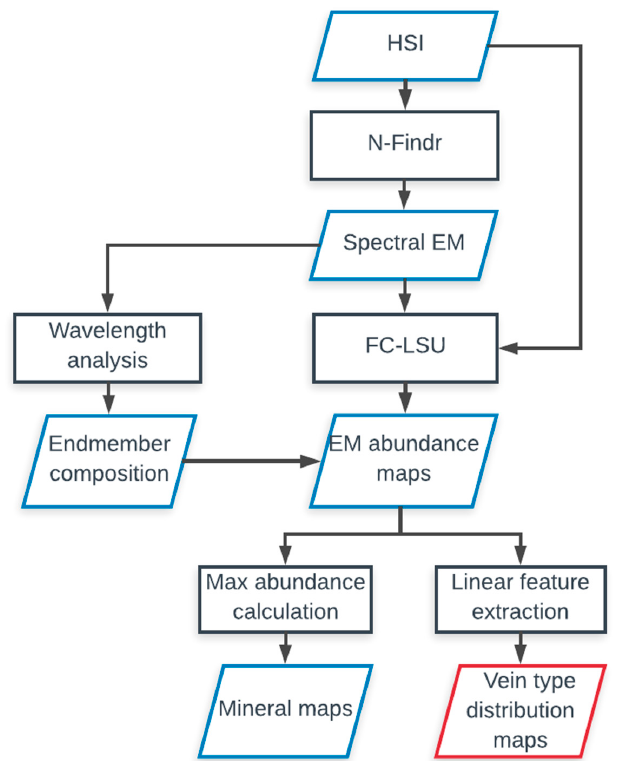
Schematic workflow of the proposed methodology (HSI = hyperspectral images, EM = endmembers, FC-LSU = fully constrained linear spectral unmixing).